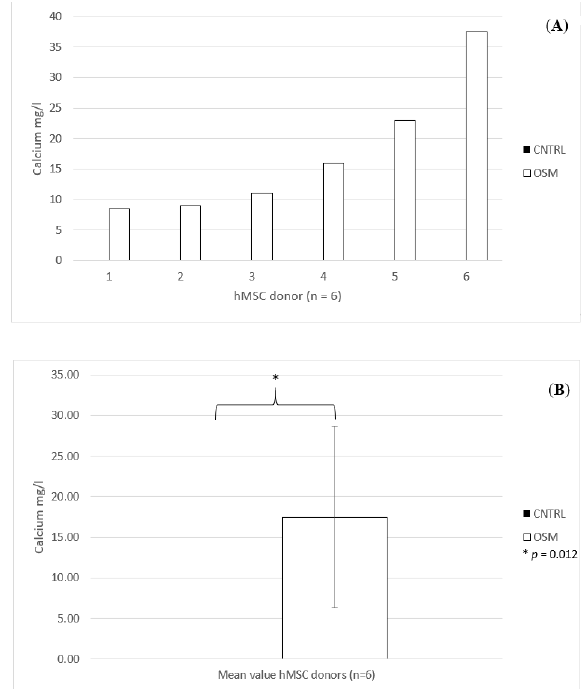
Figure 3. ( A ) Individual calcium content for each dish, donors 1–6 (n = 6 ) treated in osteogenic